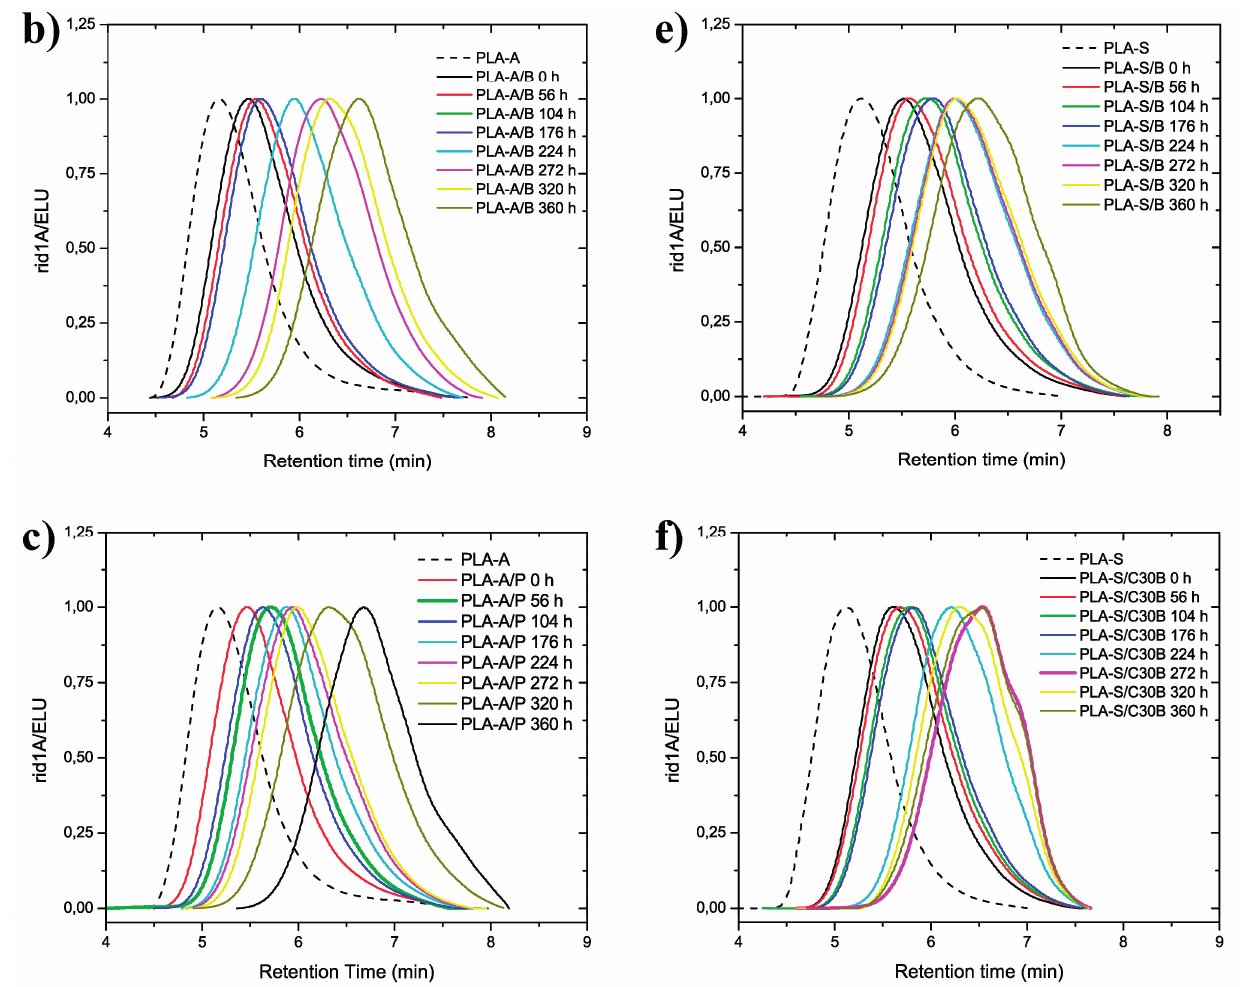
Figure 4. MWD of ( a ) PLA-A/P; ( b ) PLA-A/B; ( c ) PLA-A/C30B; ( d ) PLA-S/P; ( e ) PLA-S/B; ( f ) PLA-S/C30B at different times of exposure to artificial